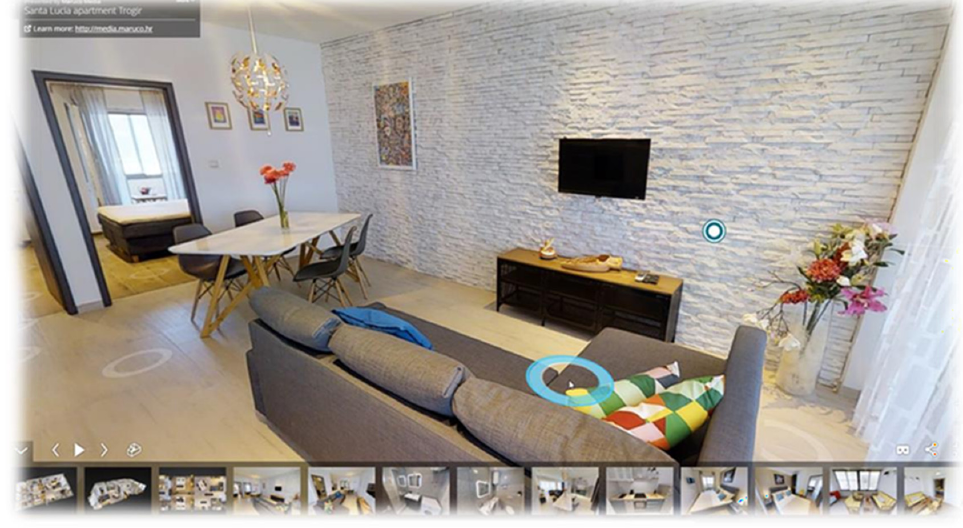
Figure 3. 3D model of space. Reprinted/adapted with permission from Matterport website [79].